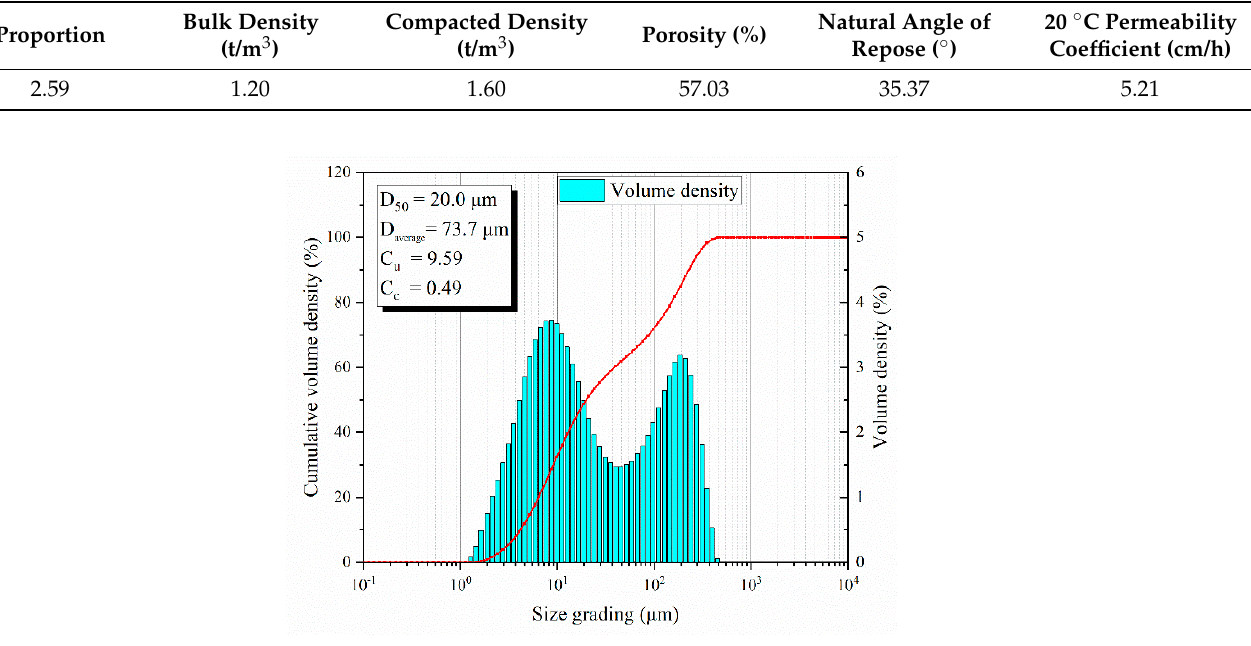
Figure 2. Particle-size distribution of experimental tailings.